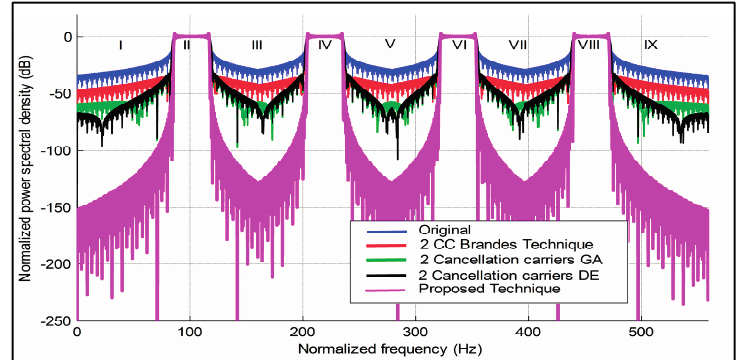
Figure 7. The PSD comparison between the proposed technique and existing techniques including CC (Brandes), CC (GA), and CC (DE).